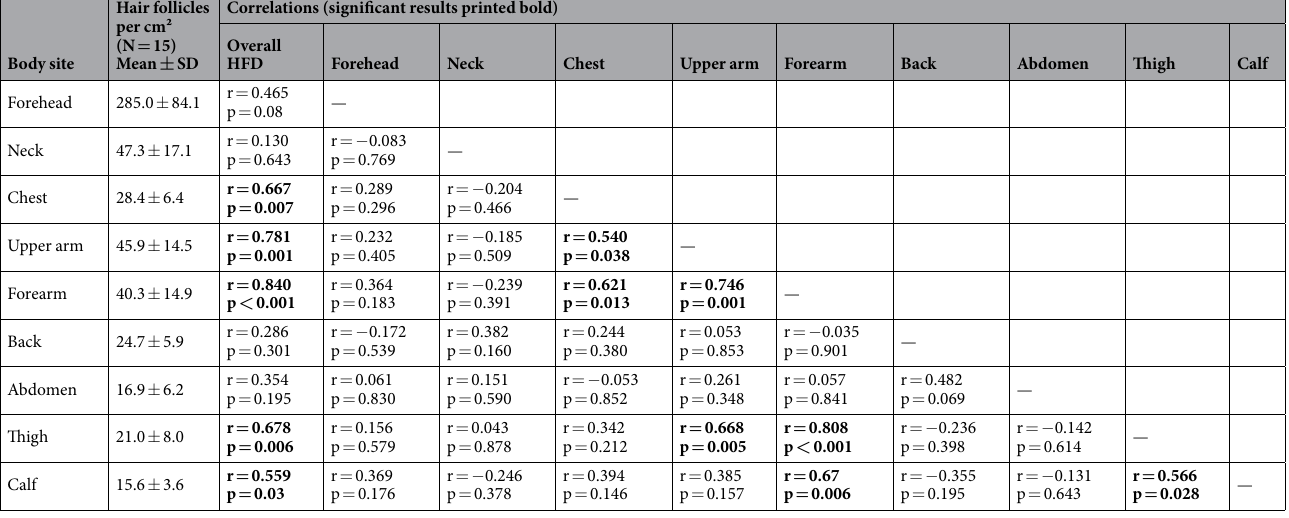
Table 2. Hair follicle densities at the 9 sampled body sites in pretest (N = 15), their correlation with the overall mean density and with each